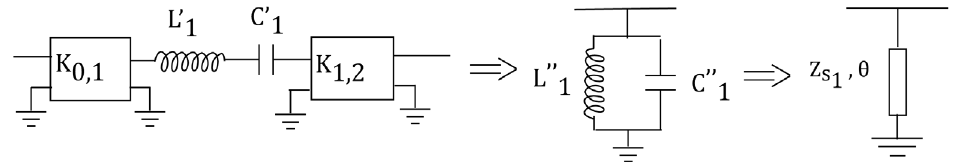
Figure 6. Short-circuited stub transformation .